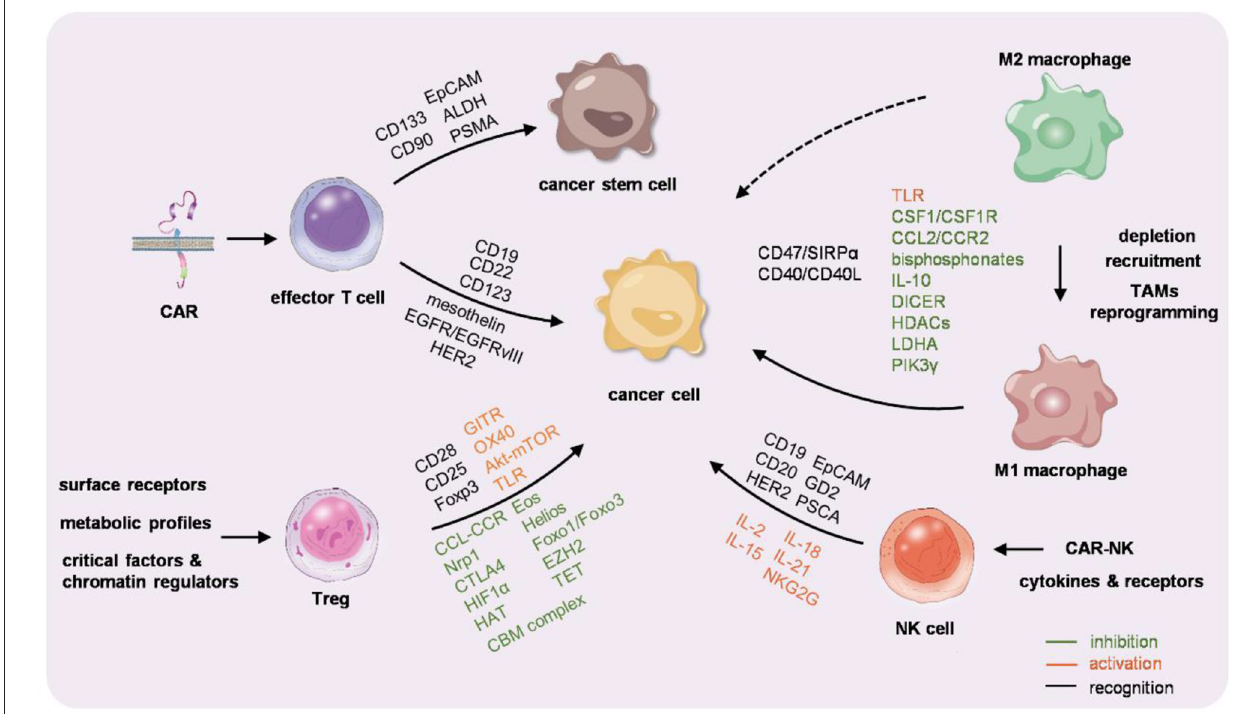
FIGURE 1 | Graphic summarization of the immunocyte-based cancer therapy. Chimeric antigen receptor-T (CAR-T) cells, macrophages, regulatory T cells (Tregs), and natural killer (NK) cells are engineered or educated either ex vivo or in vivo to reactivate the immunity against cancer.